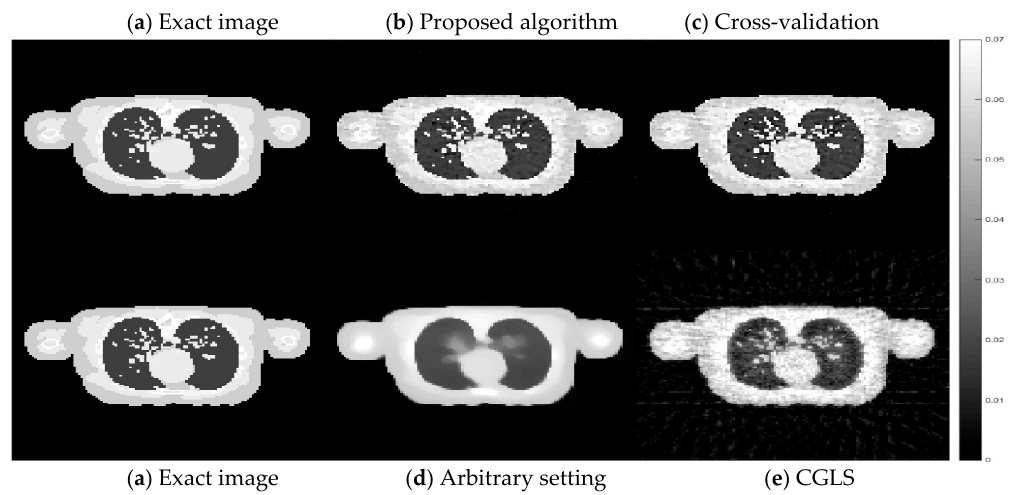
Figure 13. Cross-sectional slices of the reconstructed images from the female phantom using different method and hyperparameter settings. The display window is [0–0.07].